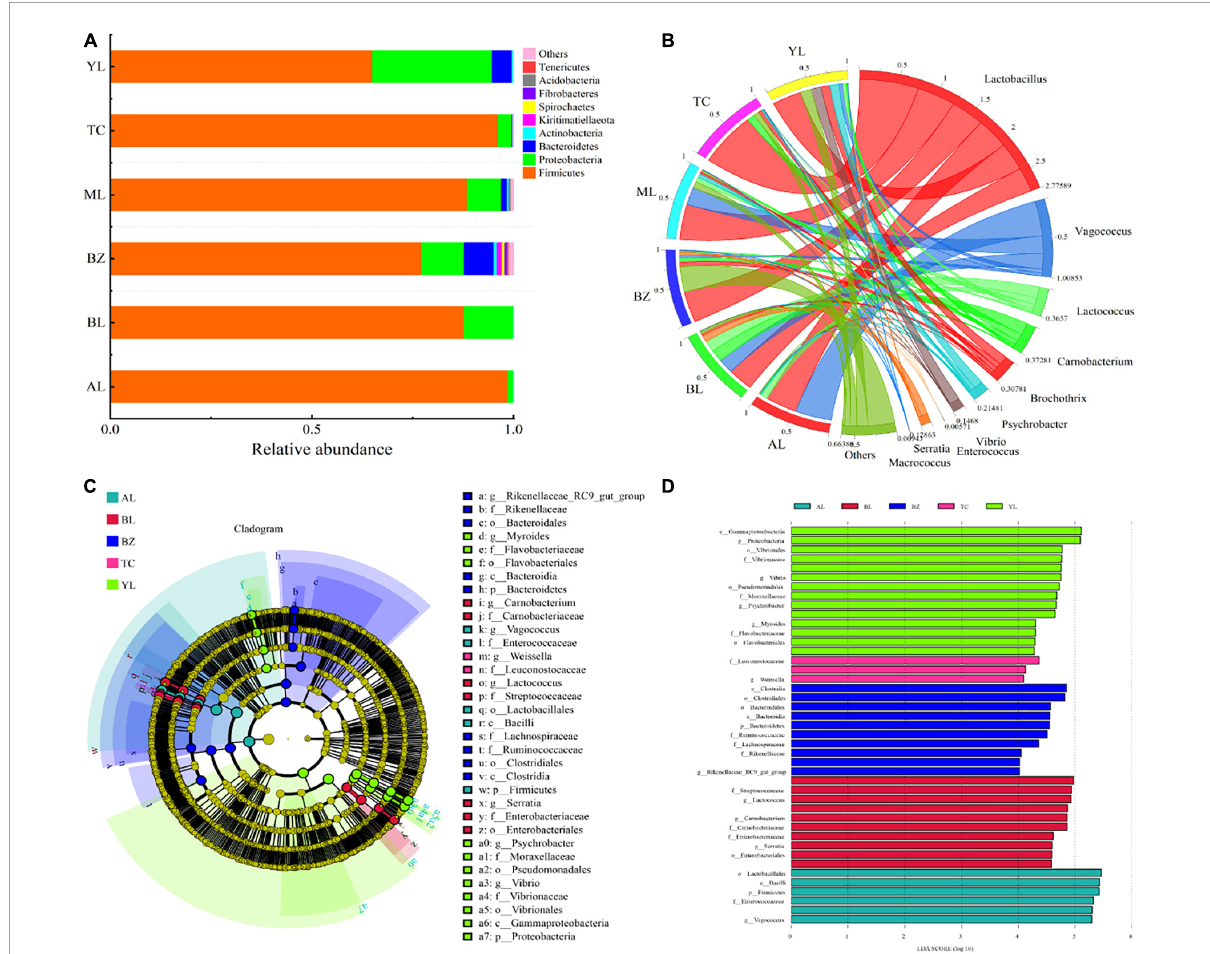
FIGURE2 Analysis of bacterial community composition and difference in different smoked horsemeat sausages. Relative abundance of bacteria at the phylum (A) and genus (B) levels. (C) Taxonomic representation of statistically and biologically consistent differences among different smoked horsemeat sausages. Colored clades represent significant differences with an LDA threshold of 4.0. (D) Histogram of the LDA scores for differentially abundant